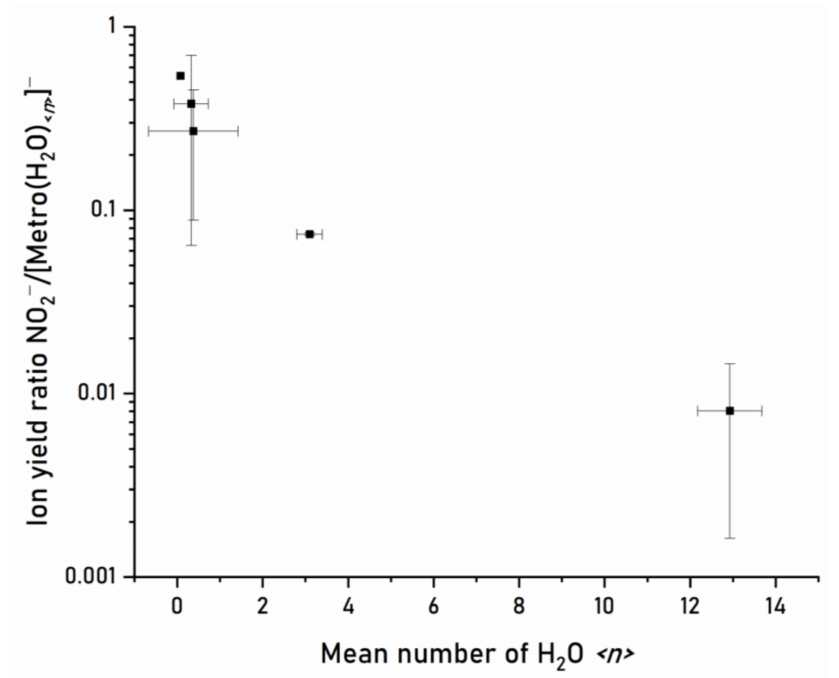
Figure 5. The ratio of the total yields of NO 2 − and Metro(H 2 O) n − parent anion at different hydration conditions, determined by the mean number < n > of water molecules attached to the parent anion in Metro(H 2 O) n − clusters. The statistical uncertainty described by the standard deviation is indicated by the error